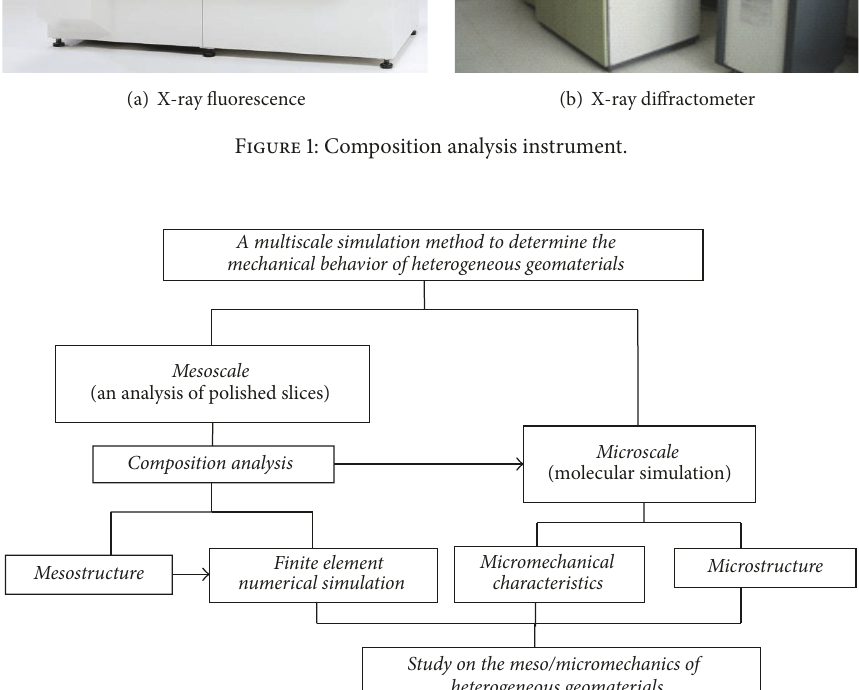
Figure 2: The technology roadmap for the